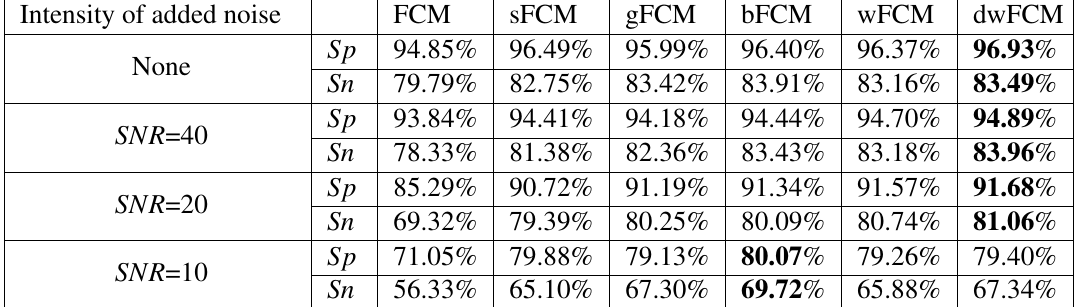
Table 2. Tumor segmentation Specificity ( Sp ) and Sensitivity ( Sn ) produced by various FCM variants and image data with Rician noise of different